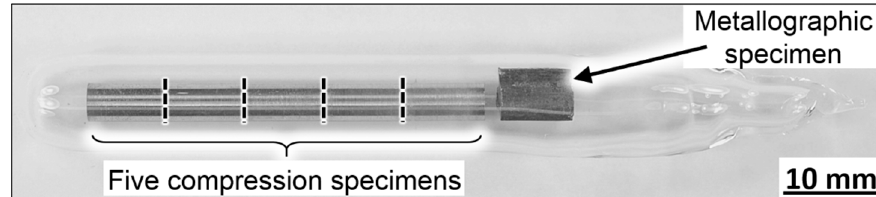
Figure 1. Photograph of five compression specimens and one metallographic sample encapsulated in an evacuated quartz tube for subsequent heat treatment.